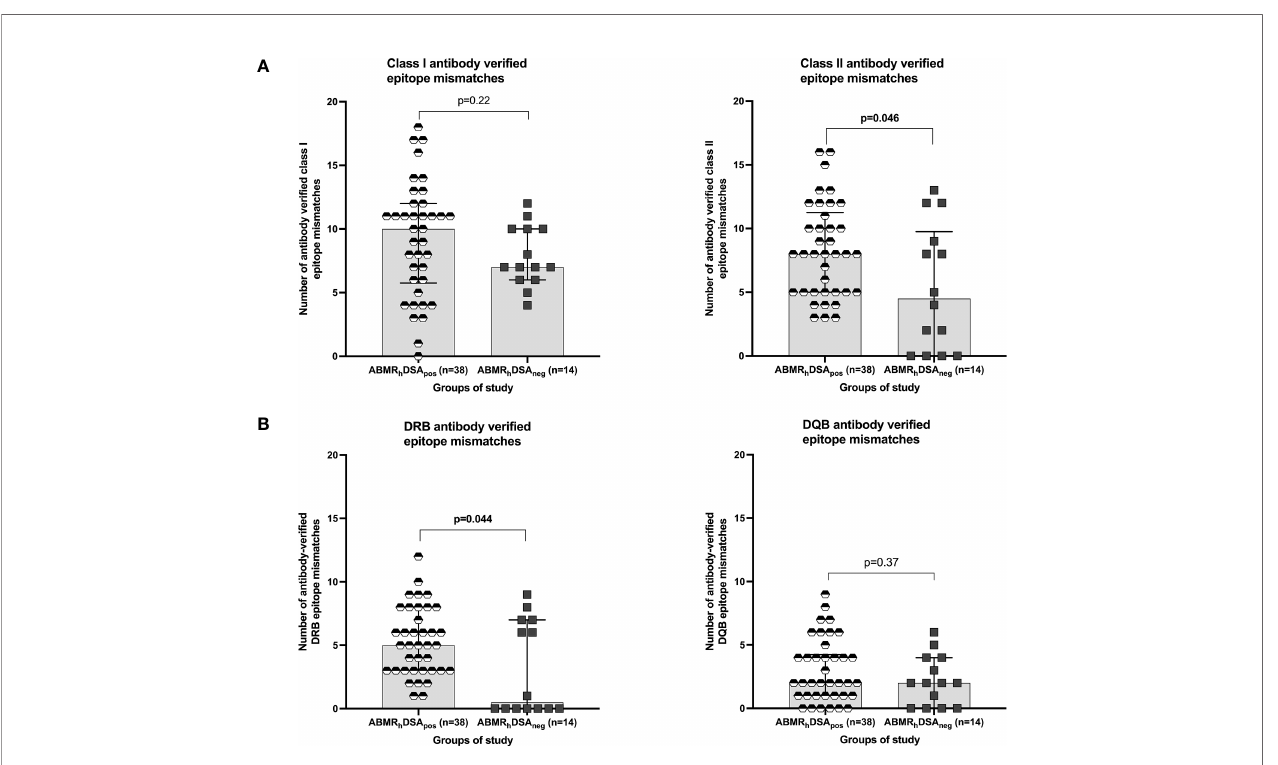
FIGURE 3 | HLA epitope mismatch analysis in ABMR h DSA pos and ABMR h DSA neg cases. (A) Number of antibody-veri fi ed class I and class II epitope mismatches and (B) Number of antibody-veri fi ed DRB and DQB epitope mismatches in ABMR h DSA pos (black and white hexagons) and ABMR h DSA neg (black squares) cases. All plots show median and interquartile range